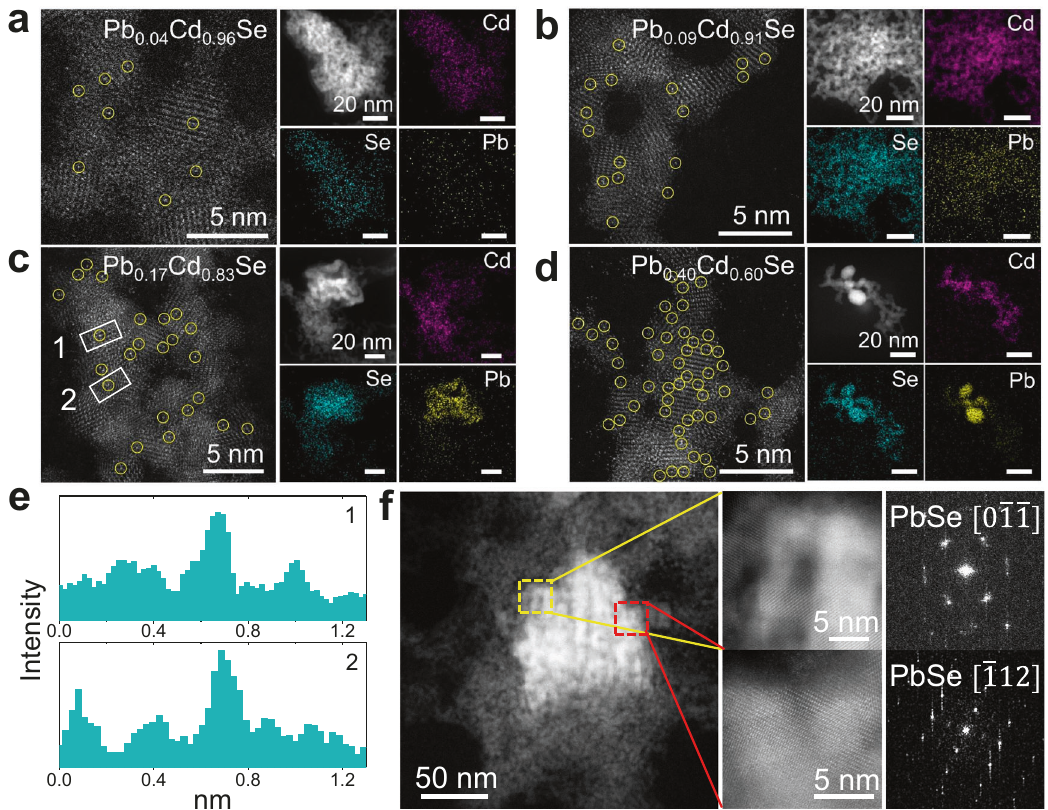
Fig. 2 HAADF-STEM characterization and EDS mapping of Pb x Cd 1 − x Se QD gels. a – d HAADF-STEM images and EDS elemental maps of a Pb 0.04 Cd 0.96 Se, b Pb 0.09 Cd 0.91 Se, c Pb 0.17 Cd 0.83 Se, and d Pb 0.40 Cd 0.60 Se QD gels. e Intensity pro fi les of Pb 0.17 Cd 0.83 Se gel in the marked area 1 and 2 in panel c . f Low- and high-magni fi cation HAADF-STEM images of a high-contrast region of Pb 0.17 Cd 0.83 Se QD gel and the corresponding FFT images from the marked regions.